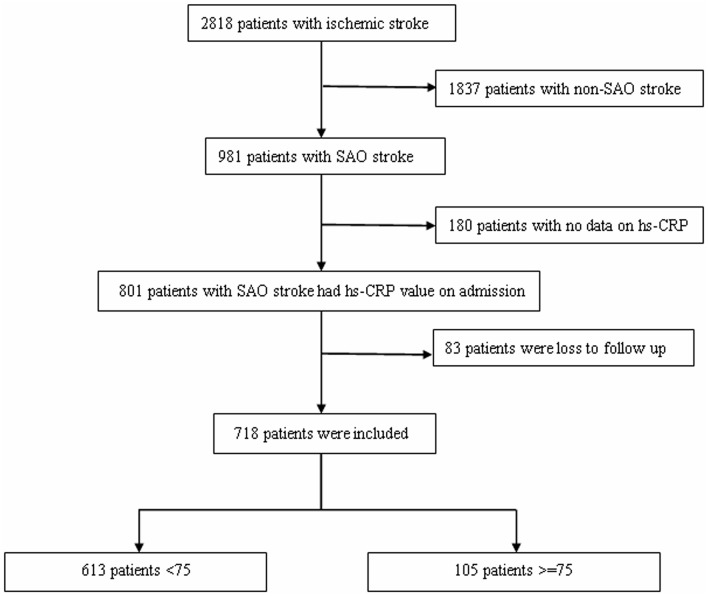
Flow chart of patient selection.